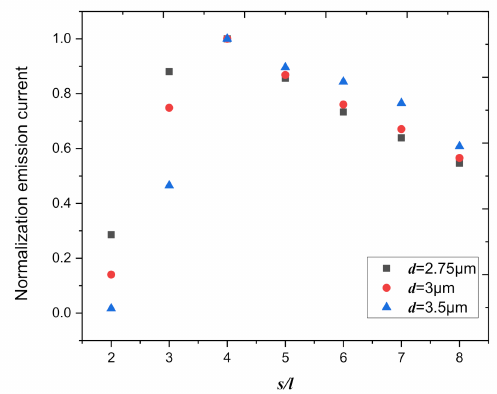
Figure 9. The normalization field emission current in 10 cm 2 as a function of the normalization spacing, for the distance between cathode and anode, is chosen to be 2.75 µ m, 3 µ m, and 3.5 µ m ( U = 200